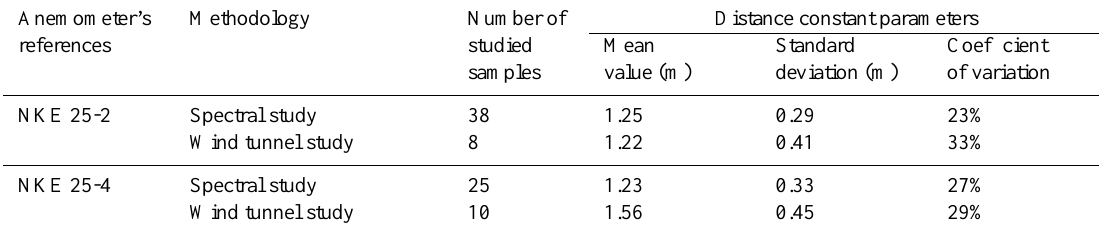
Table 4. Distance constant values determined through the spectral study (NKE 25-2: dates of 18, 23, 26 and 30 December 2002; NKE 25-4: dates of 13 and 16 July 2002, and 14 and 15 January 2003) and in the wind